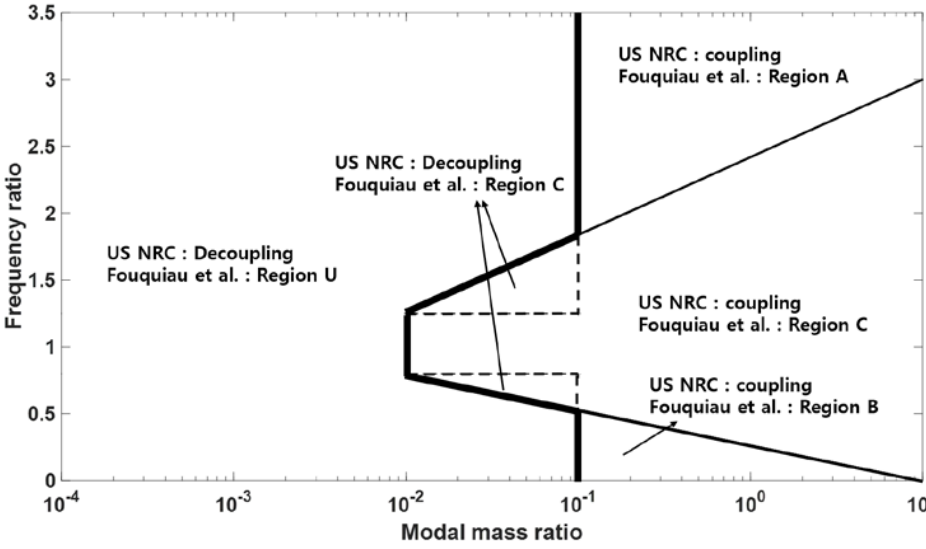
Figure 19. Decoupling criteria of US NRC [22] and Fouquiau et al.